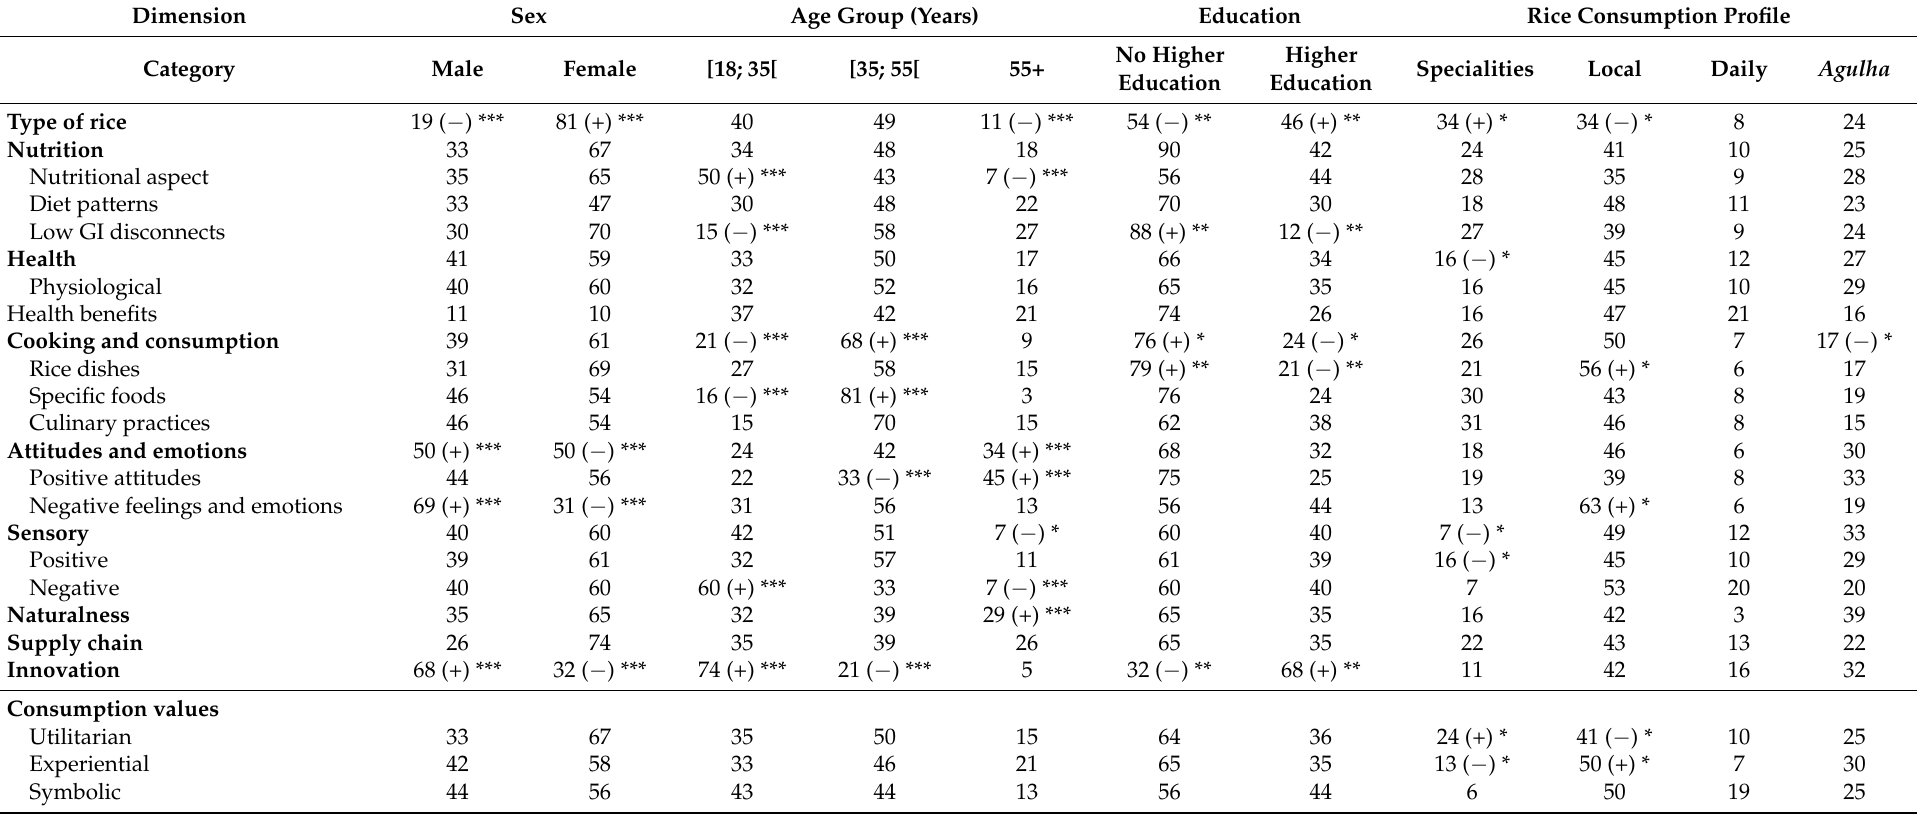
Table 7. Frequency (%) of elicited words according to dimensions, categories, and consumption values in the free word association task using the “rice with low glycaemic index” stimulus according to sex, age group, education level, and rice consumption